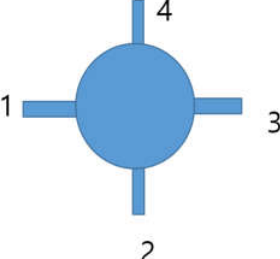
Figure 1. Fin arrangement. In this figure, numbers 1, 2, 3, and 4 represent fin numbers.